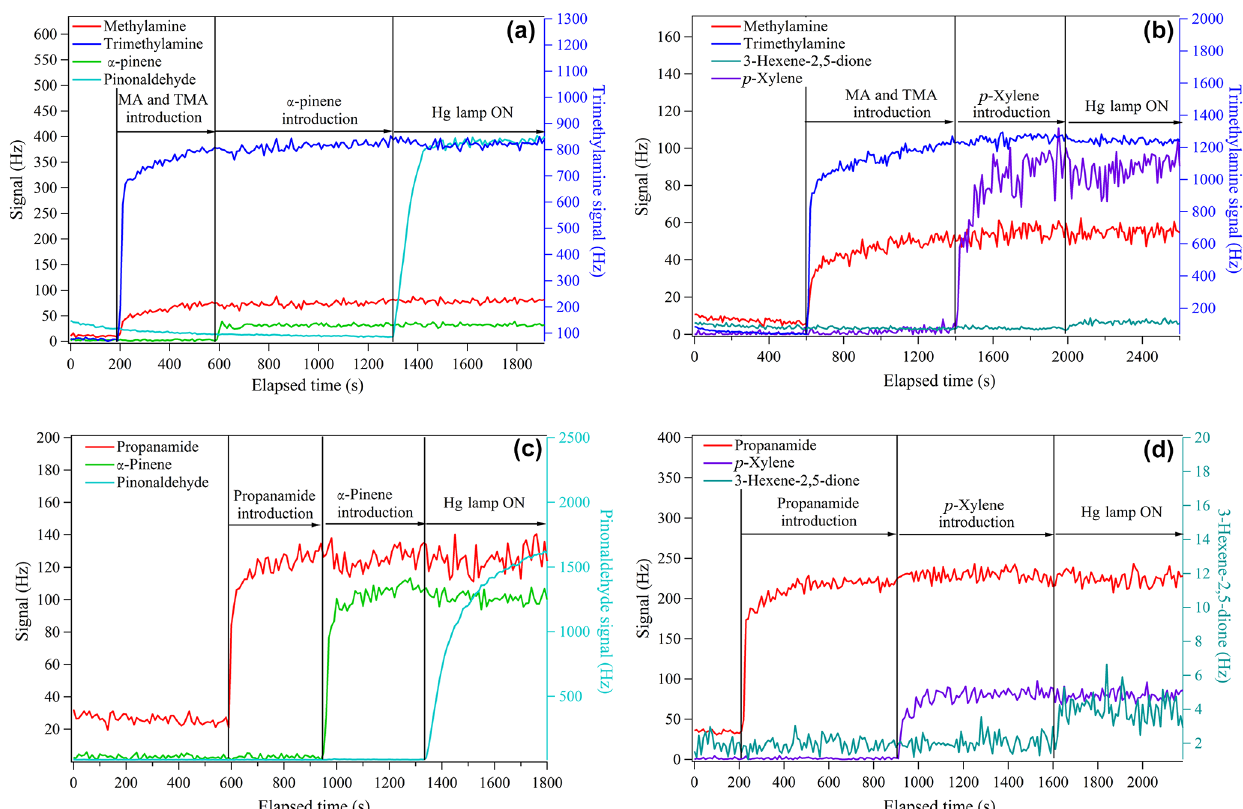
Figure 2. Influences of organics on MS signals of methylamine (MA, a and b ), trimethylamine (TMA, a and b ), and propanamide (PA, c and d ). Note that the right axis is used for the signal with an identical color, and other signals correspond to the left